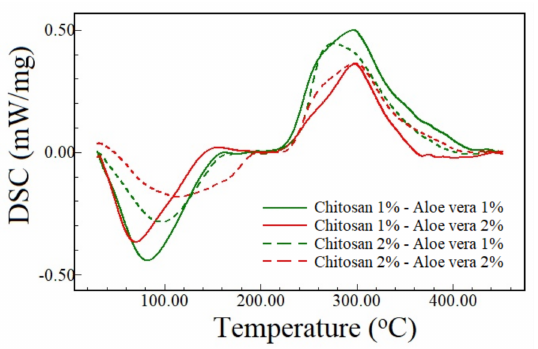
Figure 4. DSC run curves for 1% and 2% (w/w) chitosan films containing aloe vera